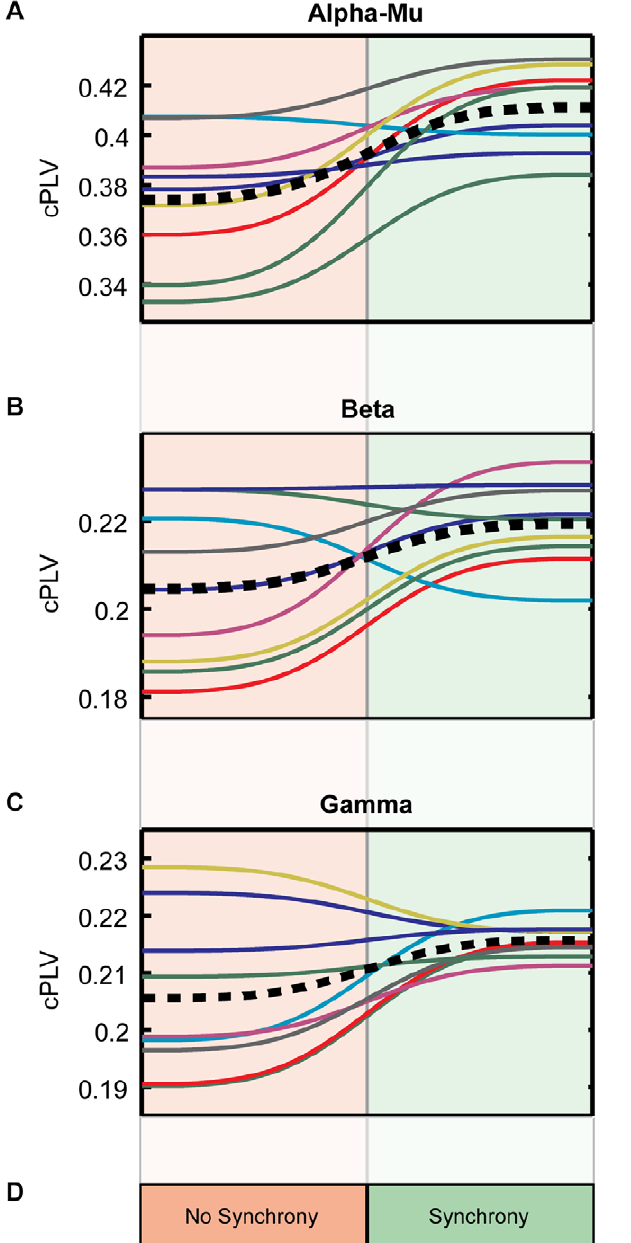
Figure 4. Summary of relevant intersubject synchronizations for all dyads according to interactional synchrony. cPLV values indicate the averaged PLVs on all pairs of electrodes members of clusters shown in Figure 2. Averages cPLV across dyads are shown in black dashed lines.